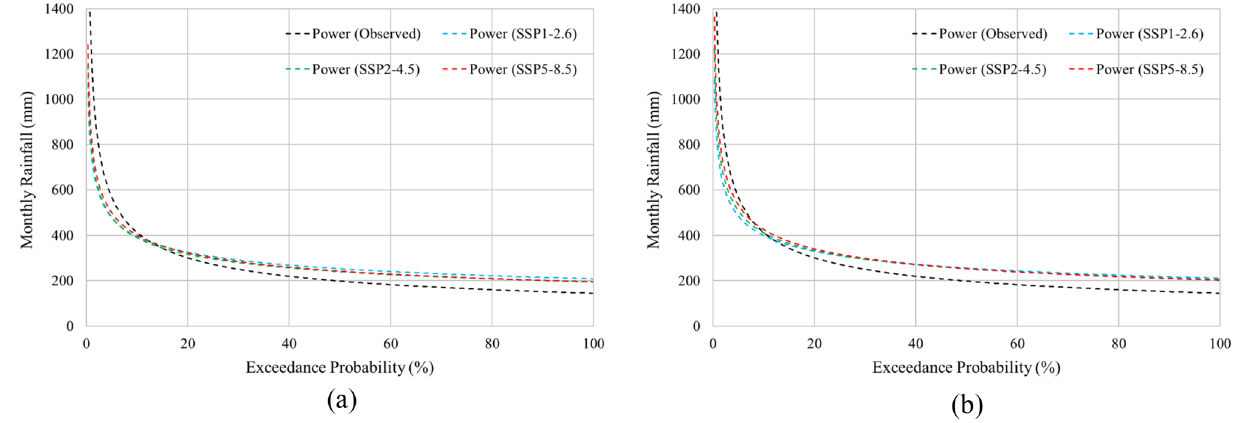
Fig. 8 Cumulative frequency distribution of the projected multi-GCM ensemble mean monthly rainfall at Kurau River Basin of observed (1976–2005) and future periods; a 2021–2051 and b 2051–2080